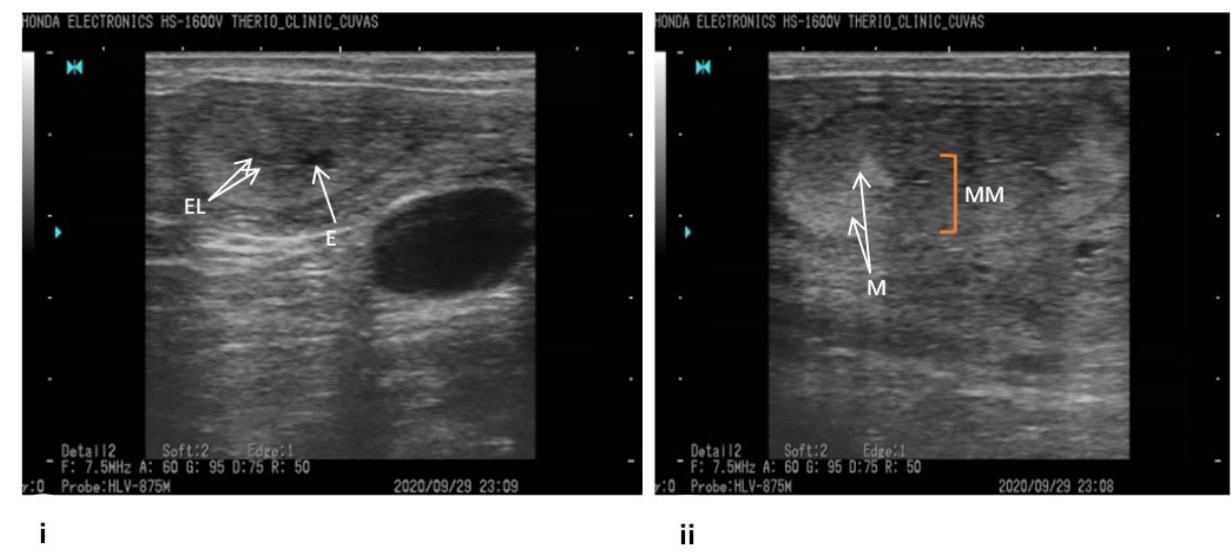
Figure 2. Ultrasonographic pictures showing endometritis in cattle. ( i ) EL—endometrial lining; E—endometrium, white arrows indicate fluid; ( ii ) MM—myometrium; M—metrium, white arrows indicate pus.